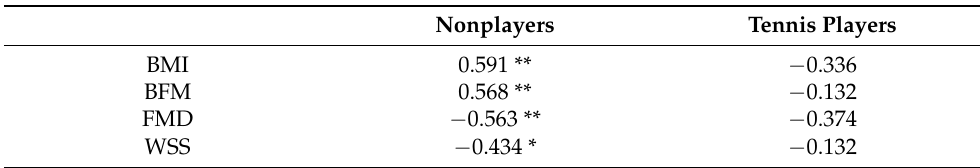
Table 2. Correlations between the measured parameters and age between the different exercise groups. Nonplayers Tennis Players